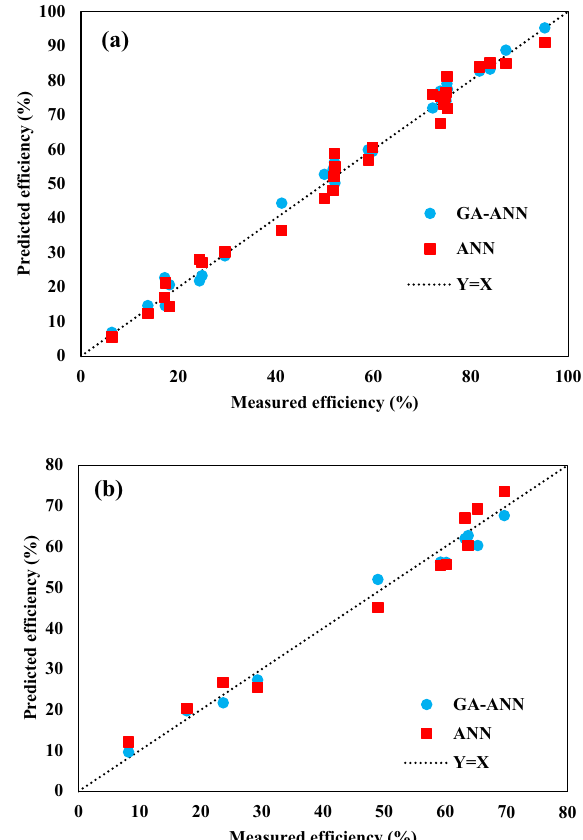
Figure 9. Correlation between predicted cerium extraction using ANN and GA-ANN methods vs. the measured cerium extraction for ( a ) training and ( b ) testing datasets.